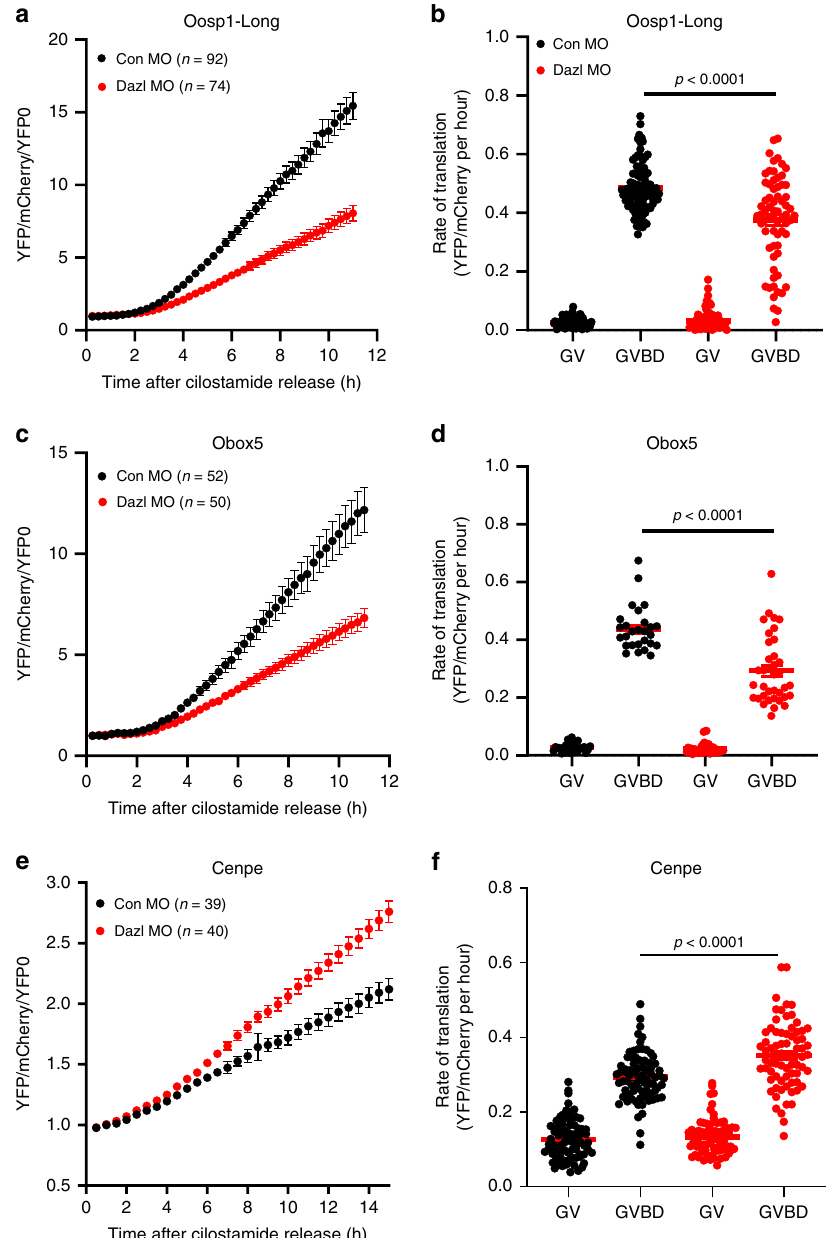
Fig. 5 The 3 ′ UTR of Oosp1, Obox5 and Cenpe recapitulates the effect of DAZL depletion on endogenous mRNA translation. Oocytes were co-injected with ployadenylated mCherry mRNA and oligoadenylated YFP-Oosp1 3 ′ UTR , YFP-Obox5 3 ′ UTR , or YFP-Cenpe 3 ′ UTR reporters with either CON-MO or DAZL- MO. Oocytes were then pre-incubated overnight to allow the mCherry signal to reach a plateau. At the end of the preincubation, oocytes were released in cilostamide-free medium for maturation and YFP and mCherry signal were recorded by time lapse microscopy. The YFP signal was analyzed using Metamorph software (version 7.8.13.0) corrected by the level of coinjected mCherry signal and normalized to the fi rst recording of YFP/mCherry. Experiments were repeated at least three times and the data are the cumulative mean ± SEM of the three or more independent experiments. Individual oocyte YFP/mCherry signals were used to calculate the rate of translation of the reporters at the 0 – 2 h (prior to GVBD) and 4 – 8 h (after GVBD) as detailed in the Methods. The differences between rates of YFP-Oosp1 ( b ) YFP-Obox5 ( d ) and YFP-Cenpe ( f ) were analyzed by unpaired two tailed t rates of translation (p < 0.0001) (Fig. 5f), con fi rming that DAZL depletion affects the translation of these reporters during maturation. Consistent with our RiboTag IP/RNA-Seq data (Supplementary Fig. 8a – f), the translational ef fi ciency of Oosp1 , Obox5 and Cenpe is affected by DAZL depletion (Supplementary Fig. 8g – i). CcnB1 3 ′ UTR co-injected with either CON-MO or DAZL-MO shows no obvious changes in translational accumu-